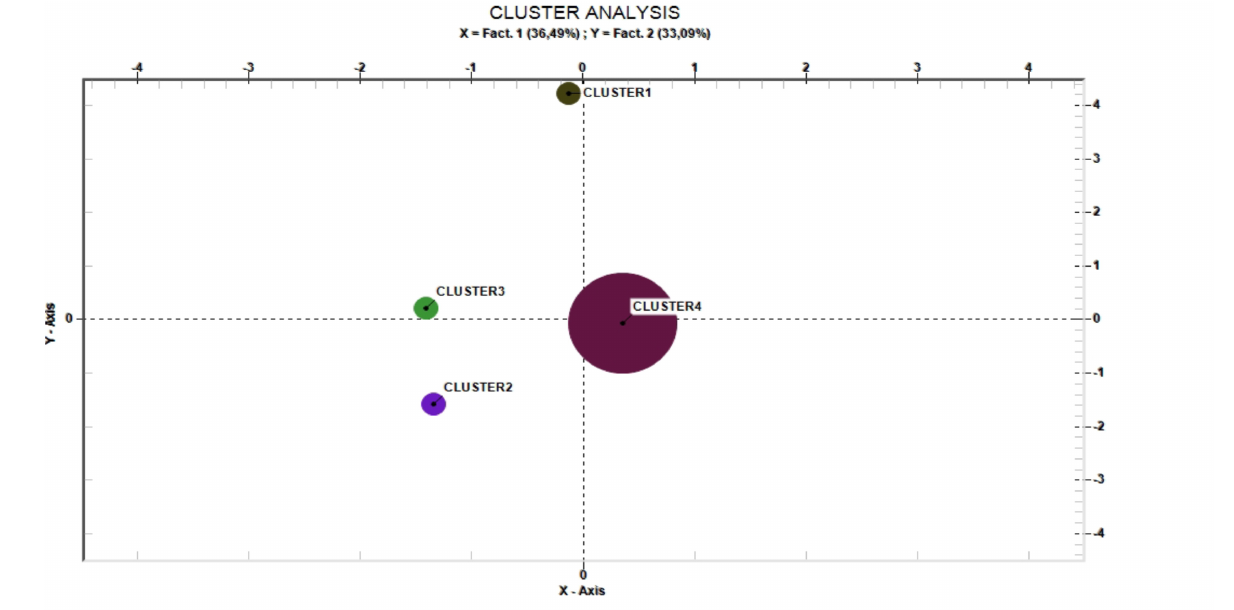
FIGURE 1 | Cluster analysis. Cluster 1, Lack of Future (10%); Cluster 2, Future Planning (10%); Cluster 3, Career Paths (10%); Cluster 4, Dark Future